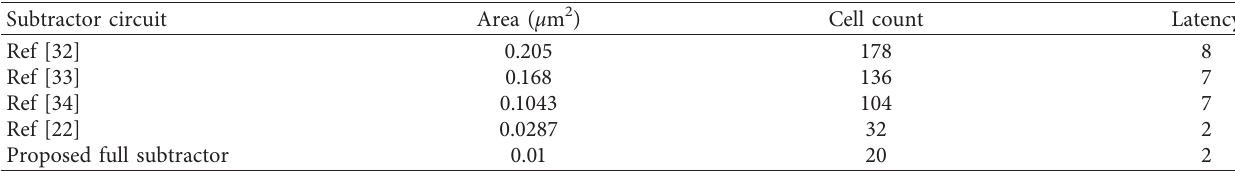
Figure 5: (a) The layout of the proposed full adder and (b) its simulation results. Table 1: Full subtractor comparison.